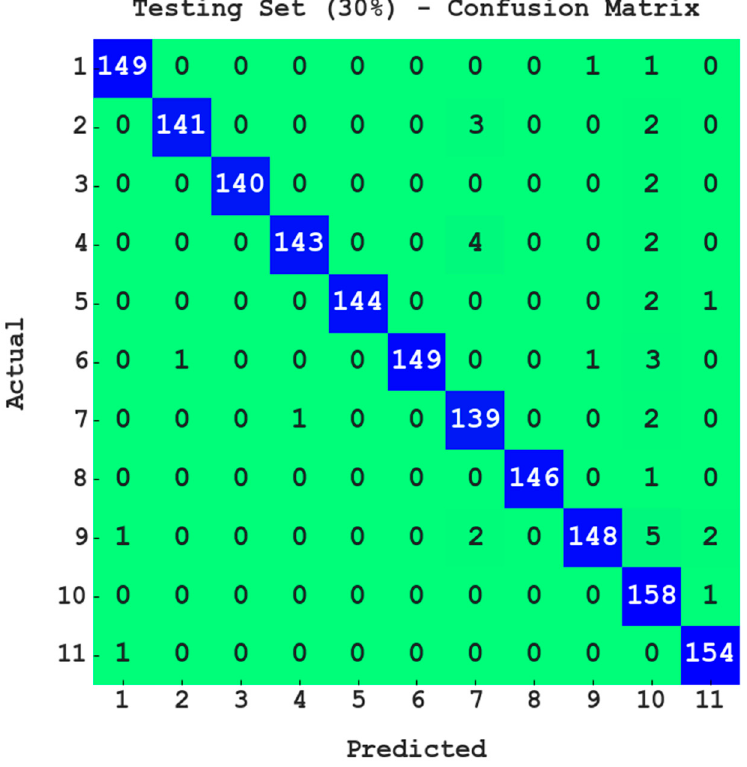
Figure 5. Confusion matrix of PODCNN-LWID approach with 30% of TS data.